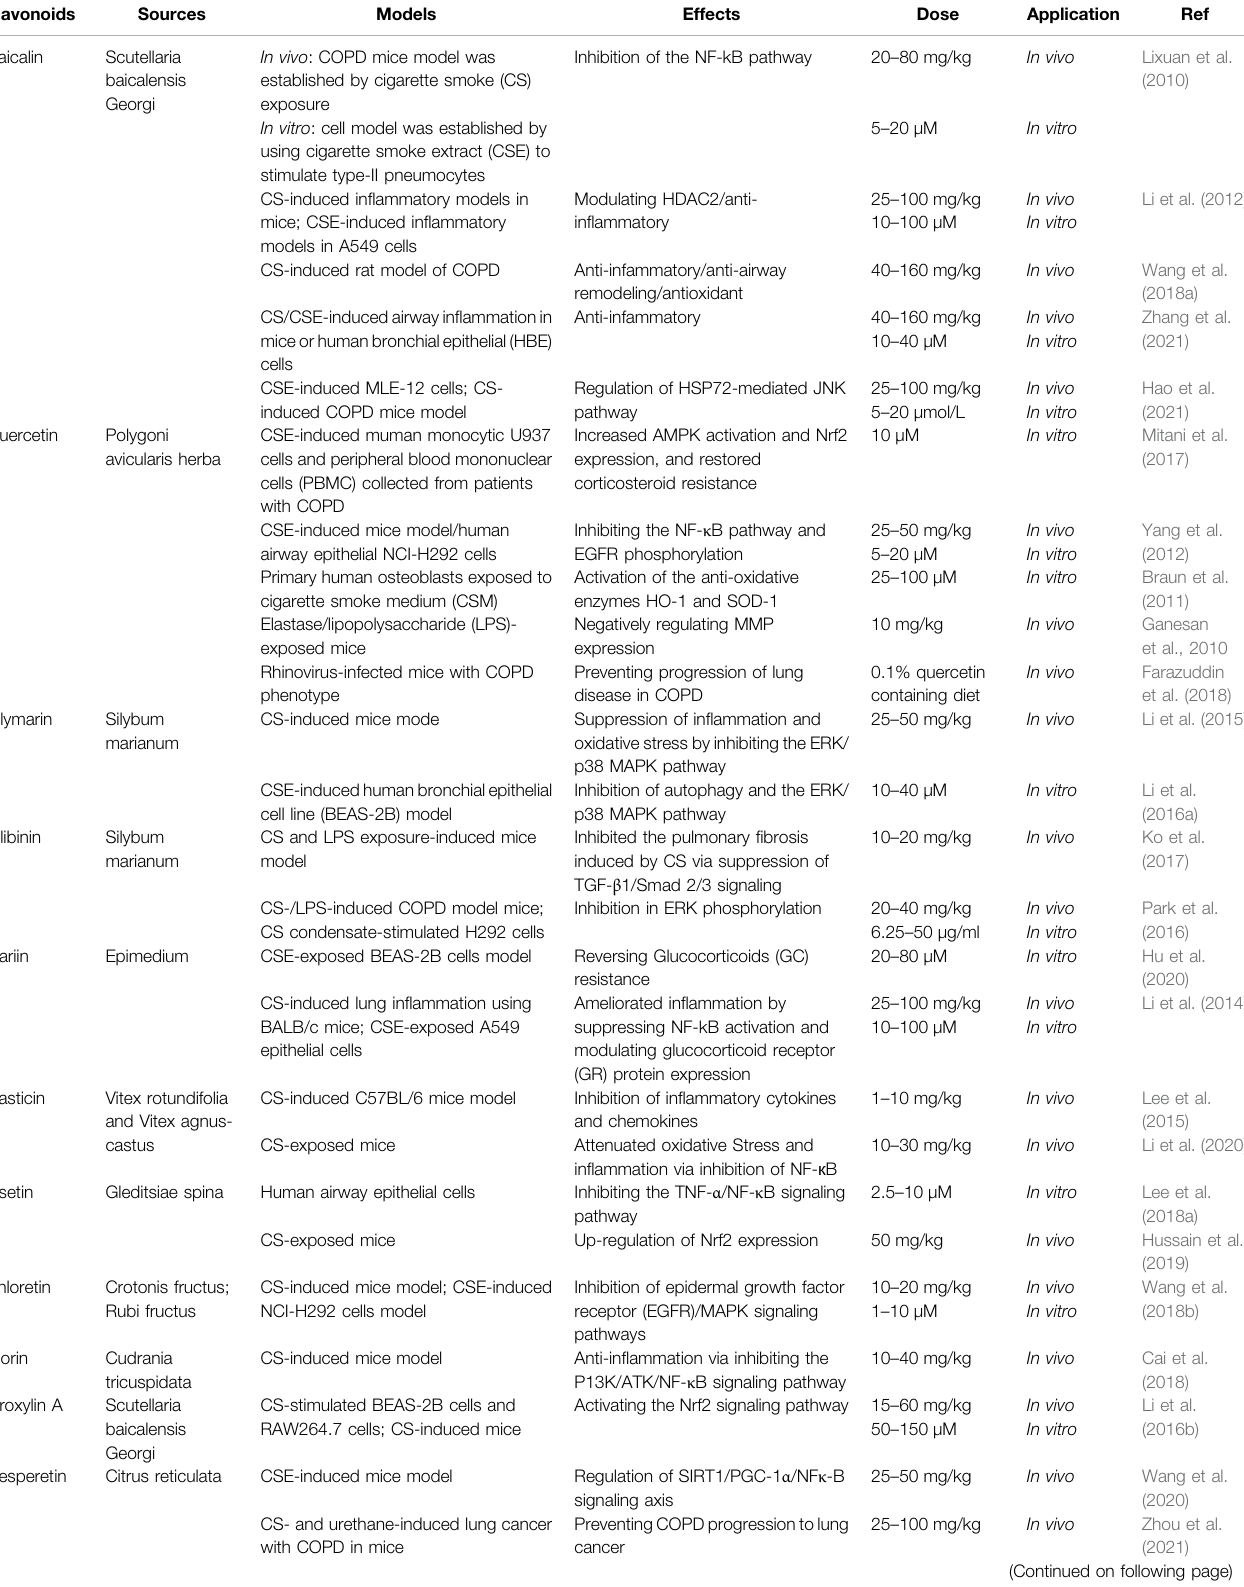
TABLE 1 | The effects of fl avonoid on